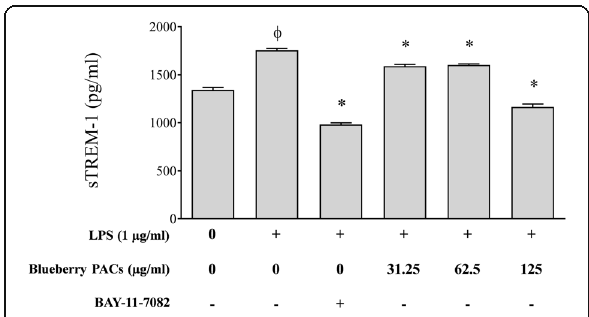
Fig. 8 Effect of highbush blueberry PACs on the secretion/shedding of sTREM-1 by macrophages stimulated with A. actinomycetemcomitans LPS . The commercial inhibitor BAY-11-7082 was used as a positive inhibitory control. Results are expressed as the means ± SD of triplicate assays from three independent experiments. Φ : significant increase ( p <0.001) compared to non-stimulated control cells. *: significant decrease ( p <0.001) compared to LPS-stimulated cells not treated